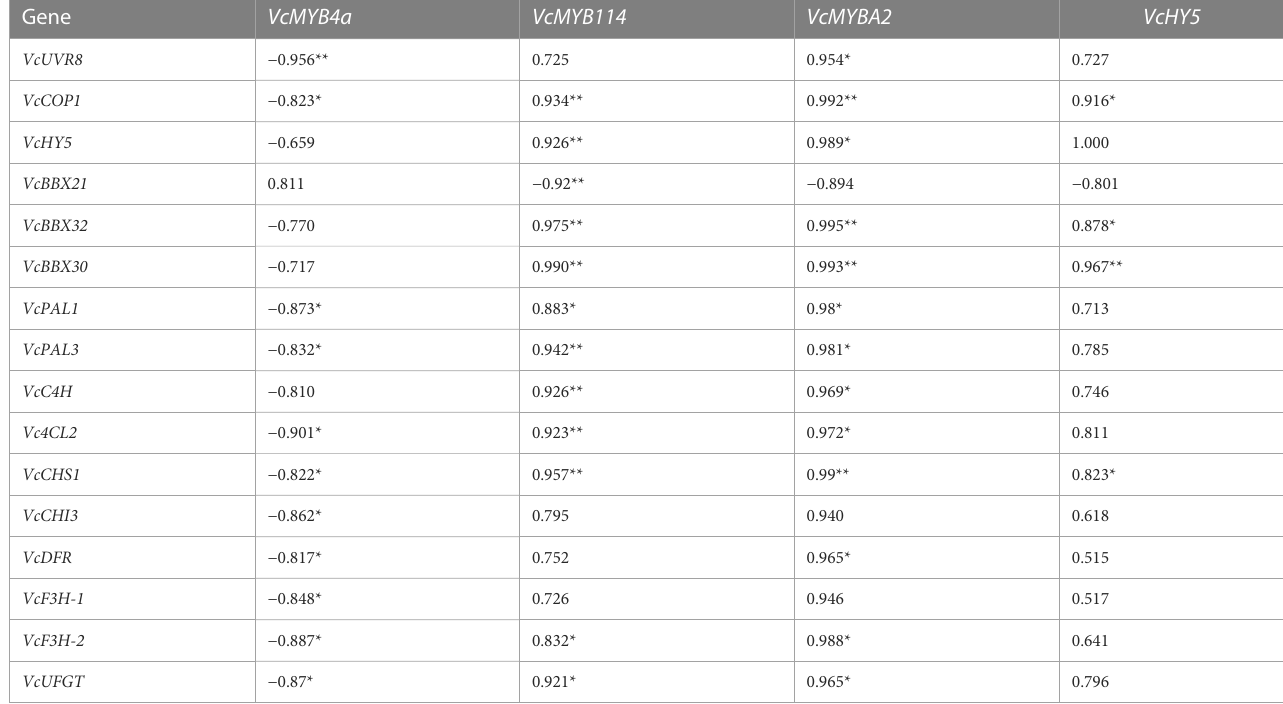
TABLE 1 Pearson ’ s correlation coef fi cients (r) between the expression levels of genes from the UV-B-induced anthocyanin biosynthesis pathway. Gene